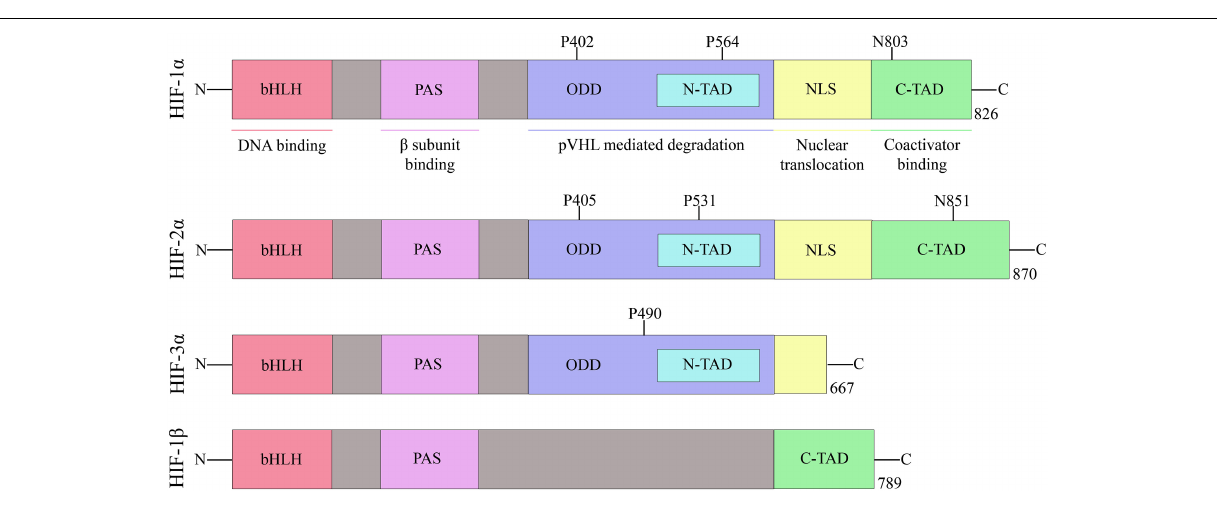
FIGURE 1 | Network showing HIF-1 connected to its target genes (adapted from: http://www.grnpedia.org/trrust/). Colors inside the shape represent the type of interaction.